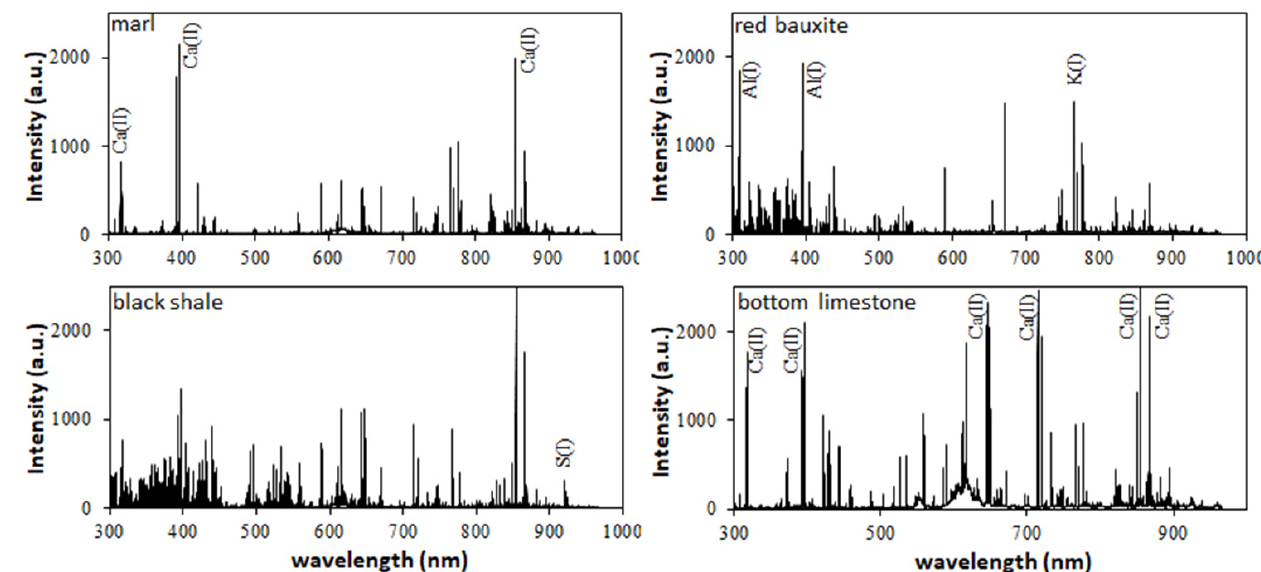
Figure 2. Exemplary LIBS spectra for marl, black shale, red bauxite, and limestone.